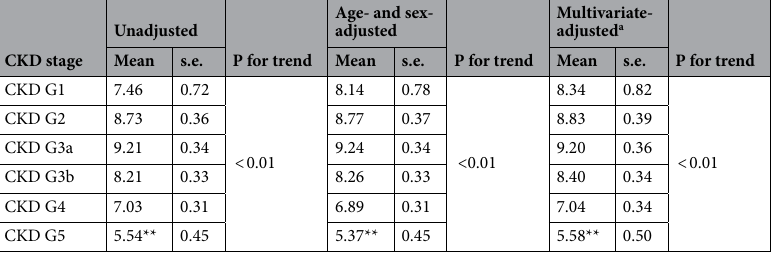
Table 7. Association between CKD stage and amount of dietary fiber only from fruits and vegetables consumed per day. CKD, chronic kidney disease; s.e., standard error. **P < 0.01 vs mean value of CKD G1. a Adjusted for age, sex, diabetes, history of cardiovascular disease, systolic blood pressure, body mass index, serum albumin concentration, low-density lipoprotein cholesterol, log-C-reactive protein, and urinary protein/ creatinine